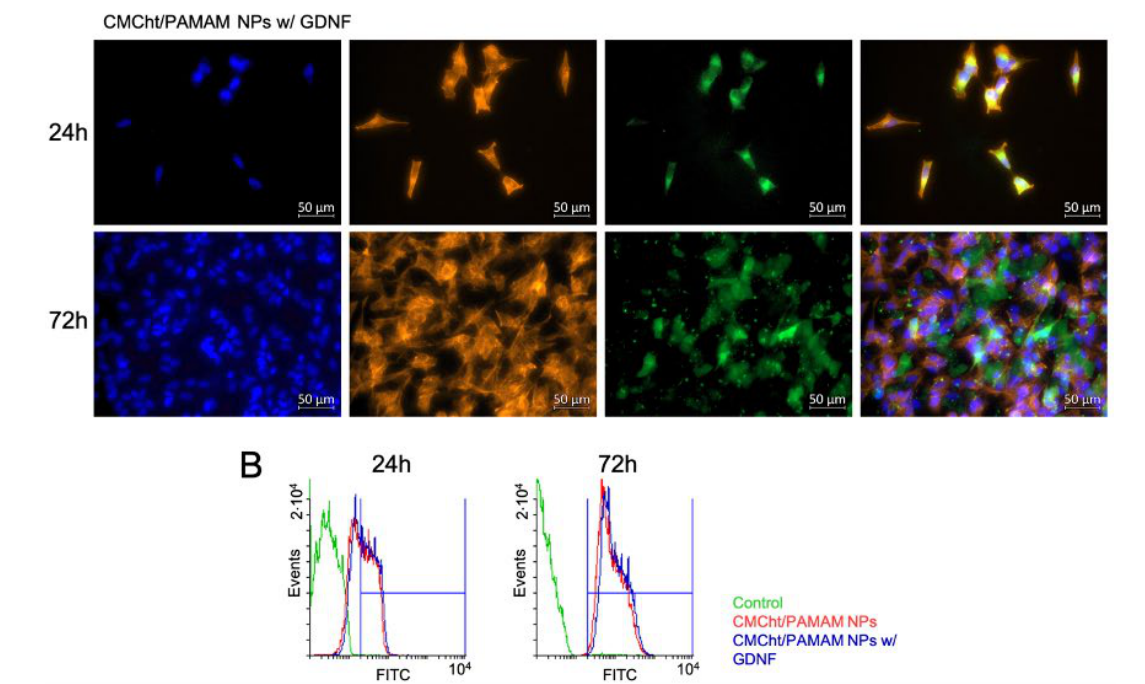
Figure 6. Uptake to SH-SY5Y cells of FITC-conjugated GDNF-loaded CMCht/PAMAM NPs. ( A ) Fluorescence images were taken at 24 h and 72 h after cells incubation in a complete medium, with the NPs and with the GDNF-loaded NPs, from top to bottom, and ( B ) Flow cytometry results at 24 h and 72 h.